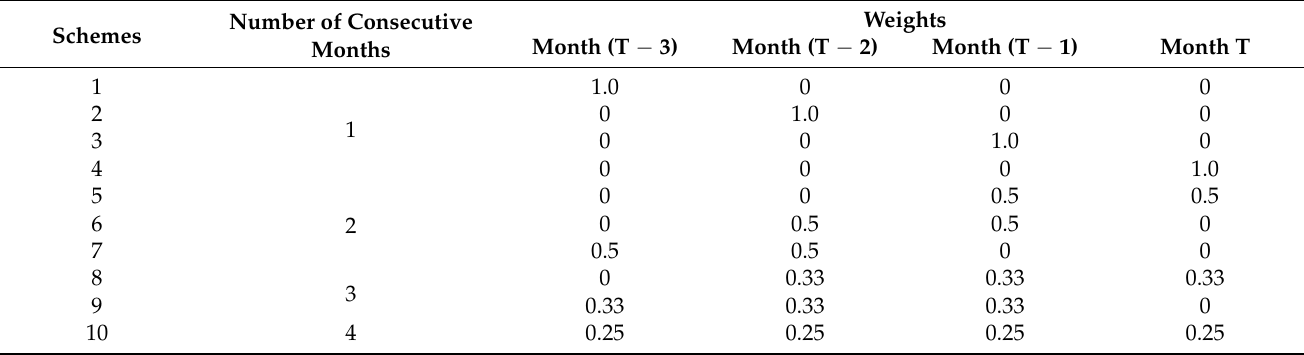
Table 1. Weight combinations of the lag-accumulation method in different months.